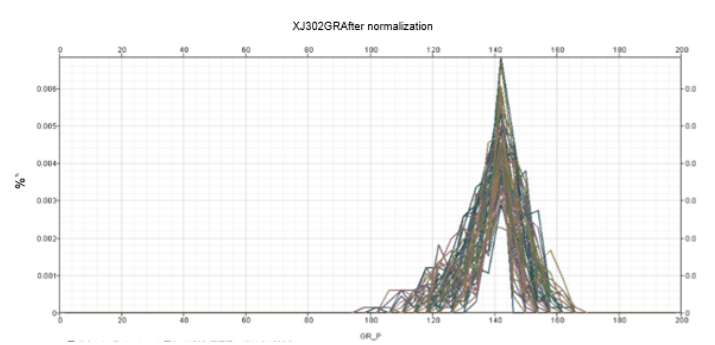
Fig. 9 GR curve distribution of standard layer after normalization.